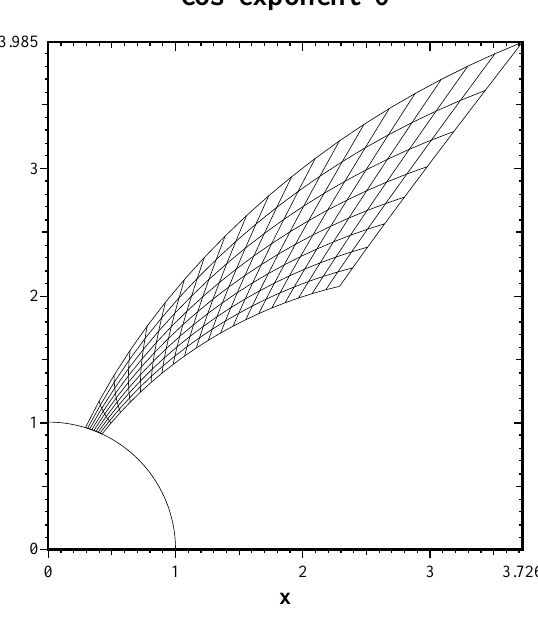
Fig. 12. The (χ,θ i ) coordinate grid in ϕ i = 0 sector with no cos θ i correction factor. χ varies between 0 and 0 .